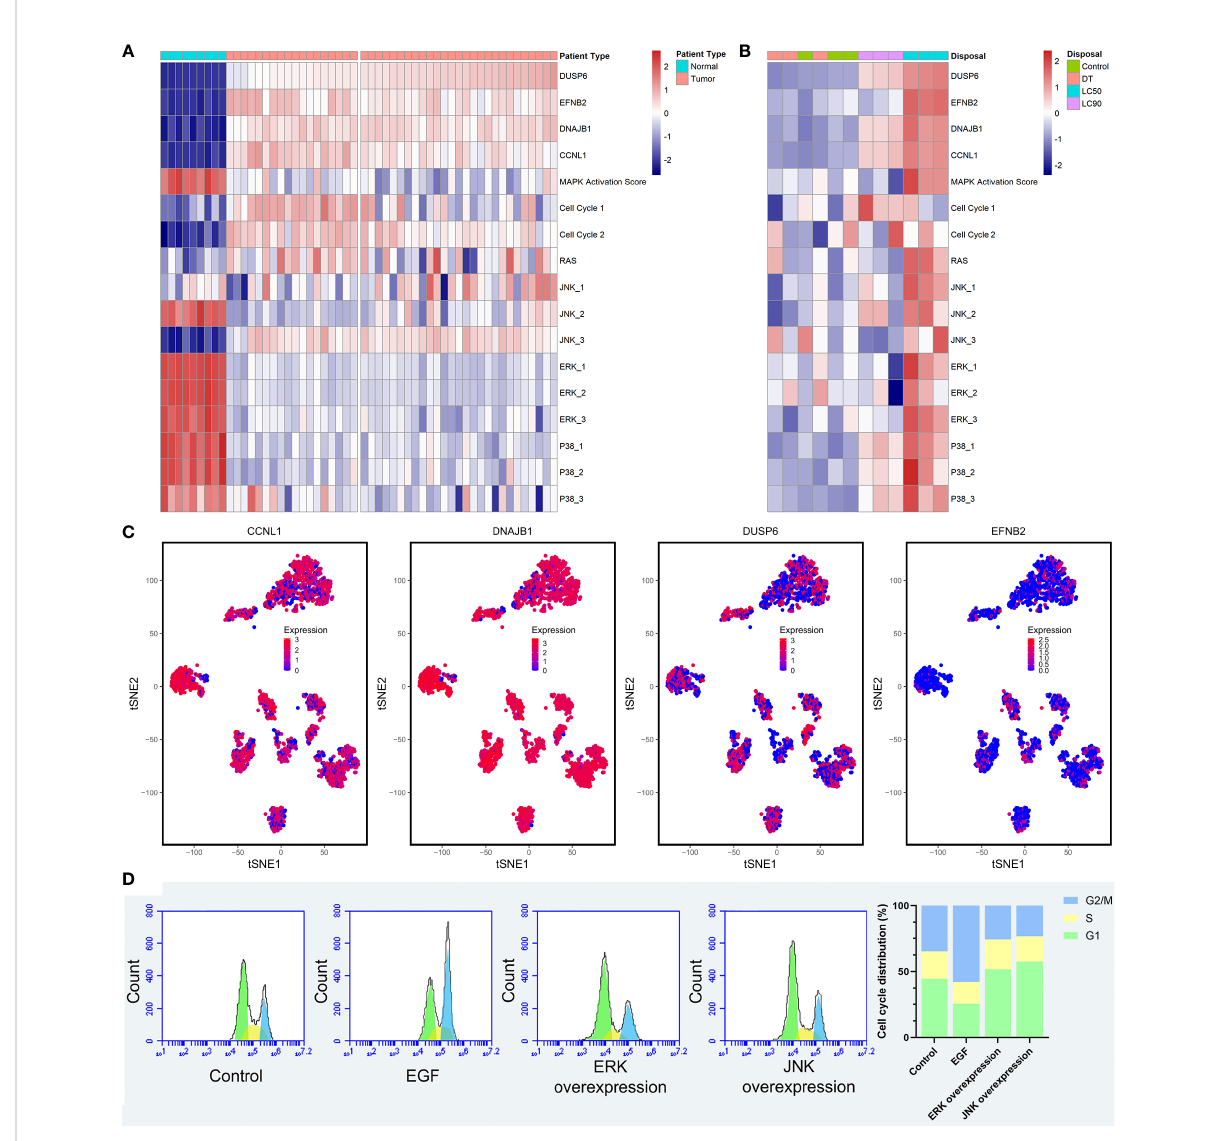
FIGURE 5 Validation of the relationship among the four SCC-PDT related genes, the MAPK pathway, and the cell cycle. (A) A heatmap of ssGESA analysis on GSE98767, which is ordered by the expression level of DUSP6. (B) A heatmap of ssGESA analysis on GSE84758, which is ordered by the expression level of DUSP6. The treatment of A431 cells was annotated at the top. (C) The tSNA plot displayed the expression level of CCNL1, DNAJB1, DUSP6, and EFNB2. (D) PI staining and fl ow cytometry were performed to estimate the A431 cell cycle phase distribution. Recombinant EGF sc-4552 (100 ng/ml), ERK activator Ceramide C6 (10 µM), and JNK activator anisomycin (500 µM) were used to treat A431 cells before PDT treatment (2.8 J/cm 2 , 635 nm). The bar chart shows the composition ratio of cells in the G1 phase, S phase, and G2/M